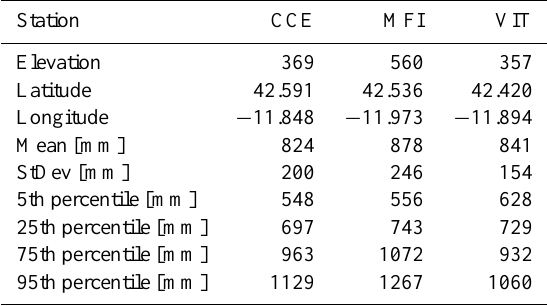
Table 1. Annual summary statistics of the three stations Castel Cellesi (CCE), Montefiascone (MFI), and Viterbo